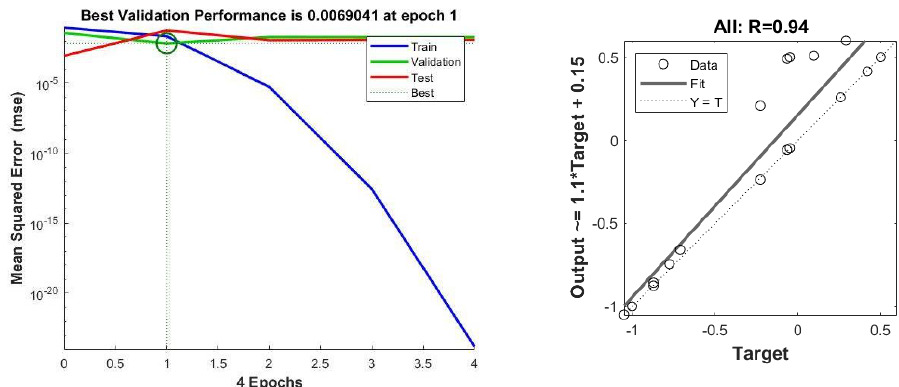
Figure 10. MSE and R 2 value for ANN1.